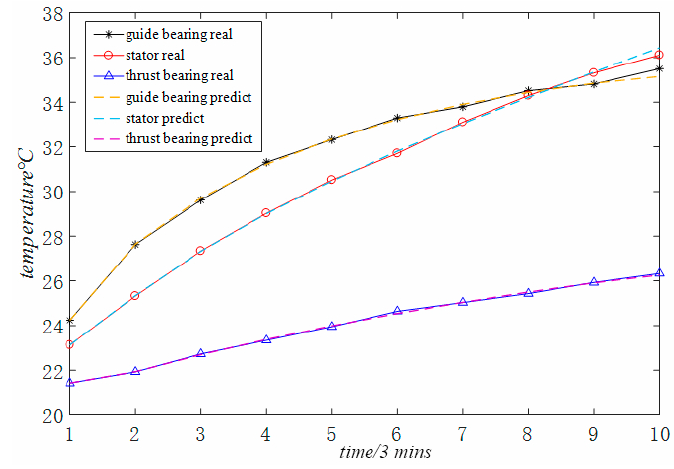
Figure 3. MGM (1, 3, q ) model prediction effect.